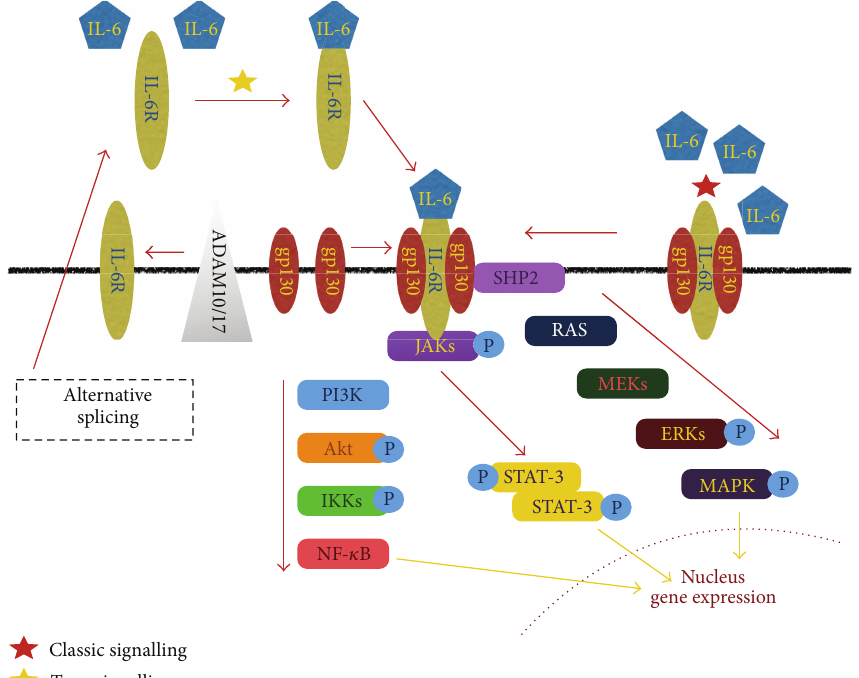
Figure 1: IL-6 signalling pathways. In classical signalling (red star), cells expressing membranous IL-6R are responsive to IL-6; in transsignalling (yellow star), cells lacking IL-6R are activated by IL-6/sIL-6R complexes (sIL-6R is generated by proteolytic shedding from IL-6R via ADAM10 and ADAM17 or by mRNA alternative splicing). Cellular events initiated by IL-6/IL-6R activity include activation of JAK, MEKs-ERKs, and PI3K/Akt kinases, resulting in changes in nuclear gene expression. IL-6: interleukin 6; sIL-6R: soluble interleukin 6